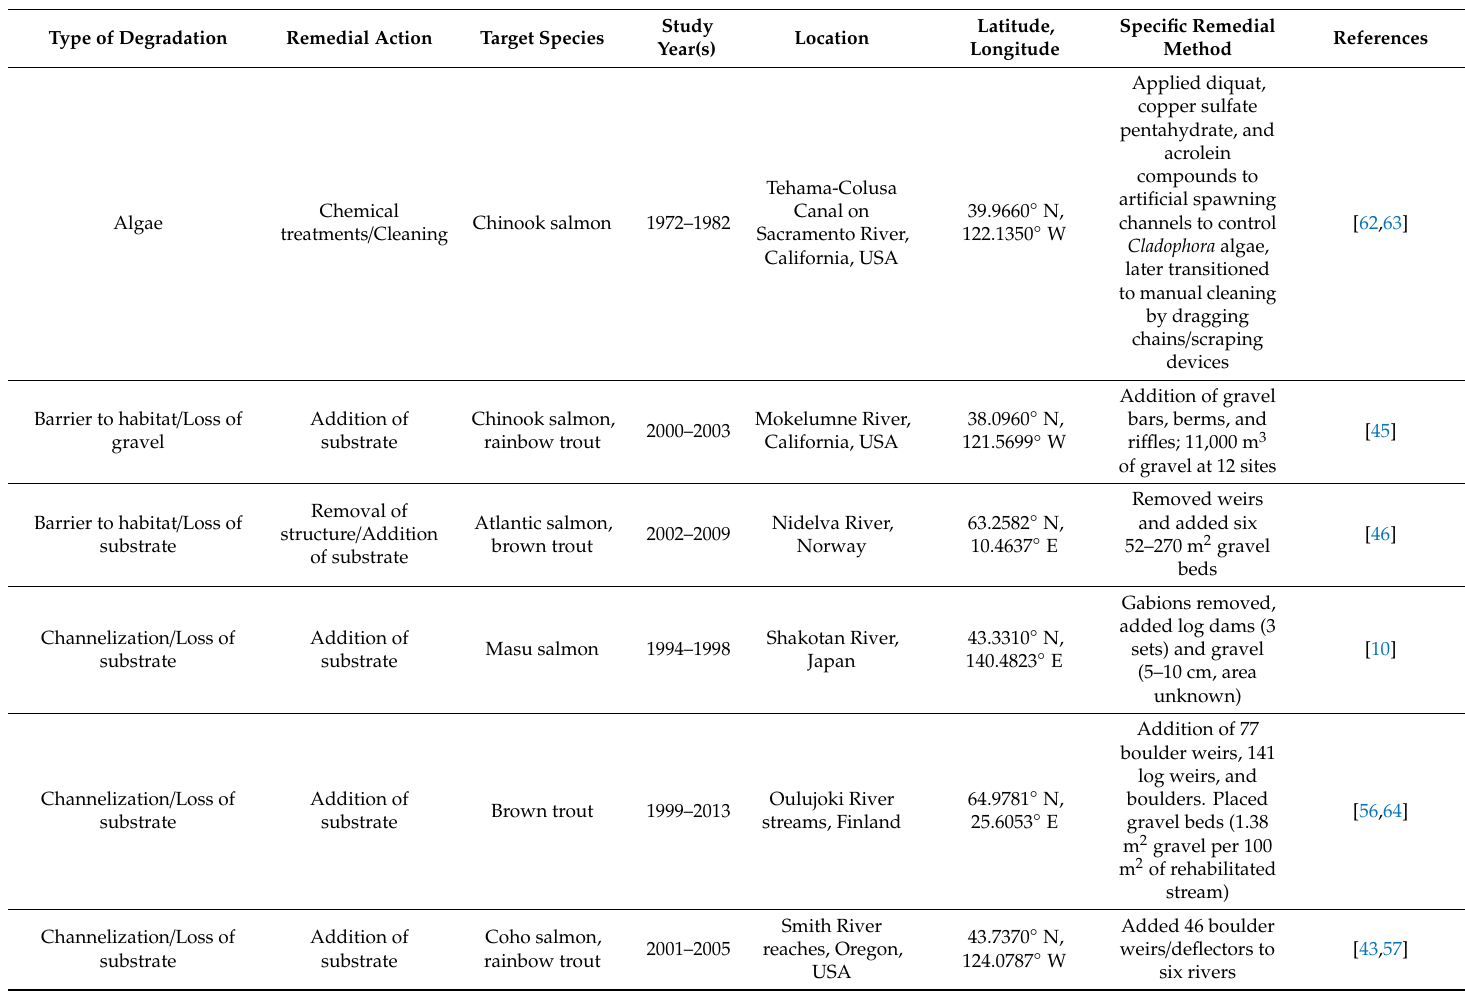
Table 1. List of rocky spawning habitat remediation projects included in a literature review of potential remediation methods sorted by the primary type of degradation a ff ecting the habitat and the first year in which the study or remediation took place. Scientific names of fish species are listed in Appendix